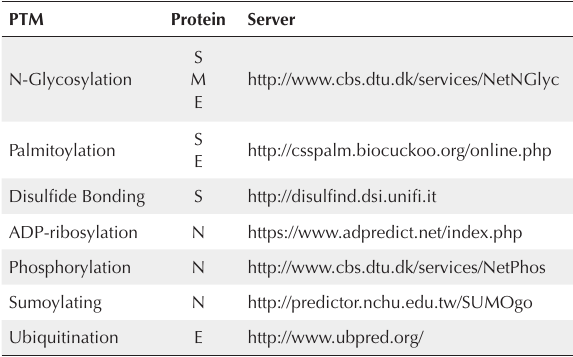
Table 1. Servers used for predicting the PTMs of SARS-CoV and SARS-CoV-2 PTM Protein Server